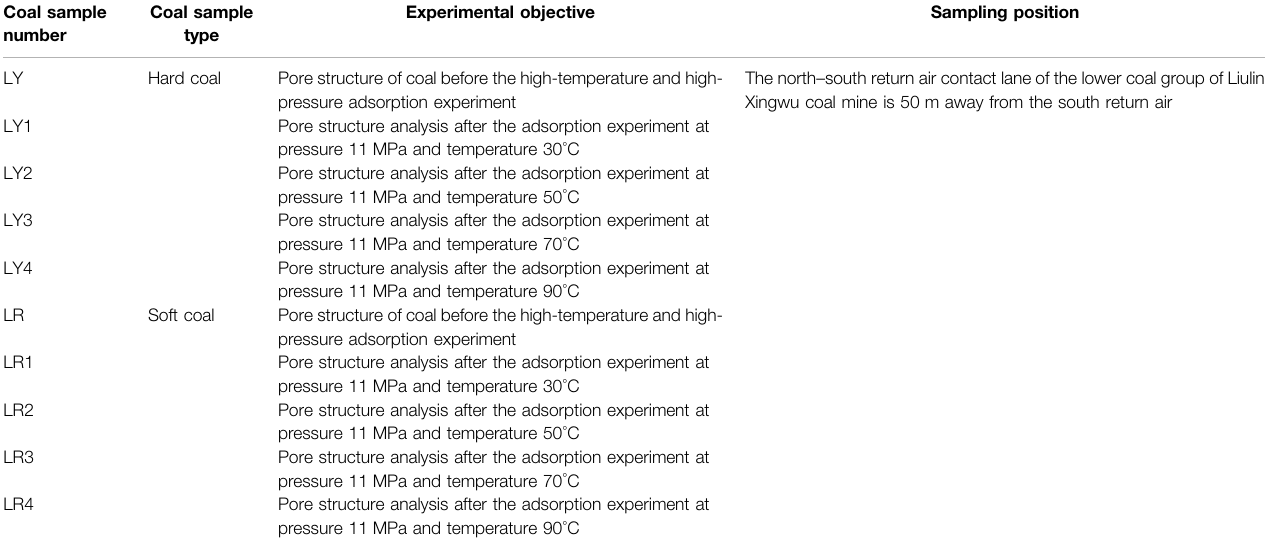
TABLE 1 | Serial number of coal samples.